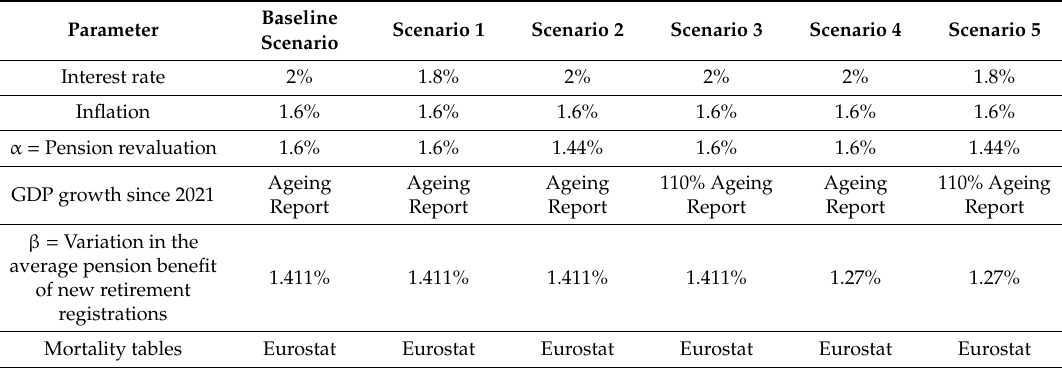
Table 5. Hypotheses adopted for the sensitivity analysis.